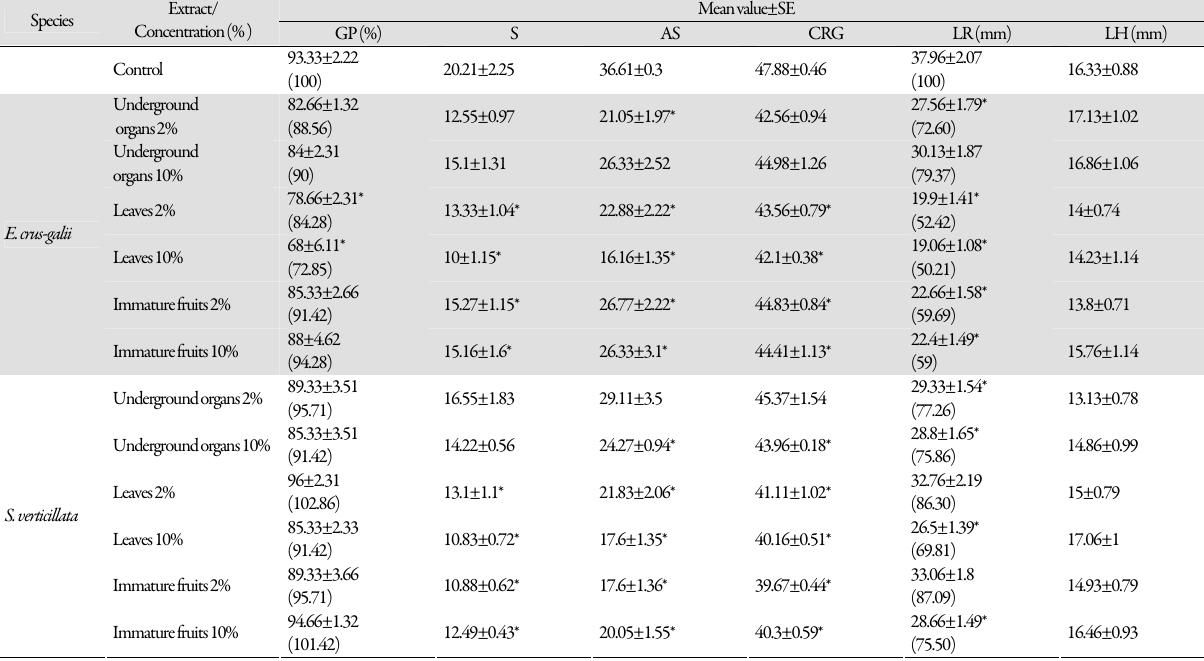
Table 2. Effect of aqueous extracts of monocotyledonous weeds on the analyzed indicators